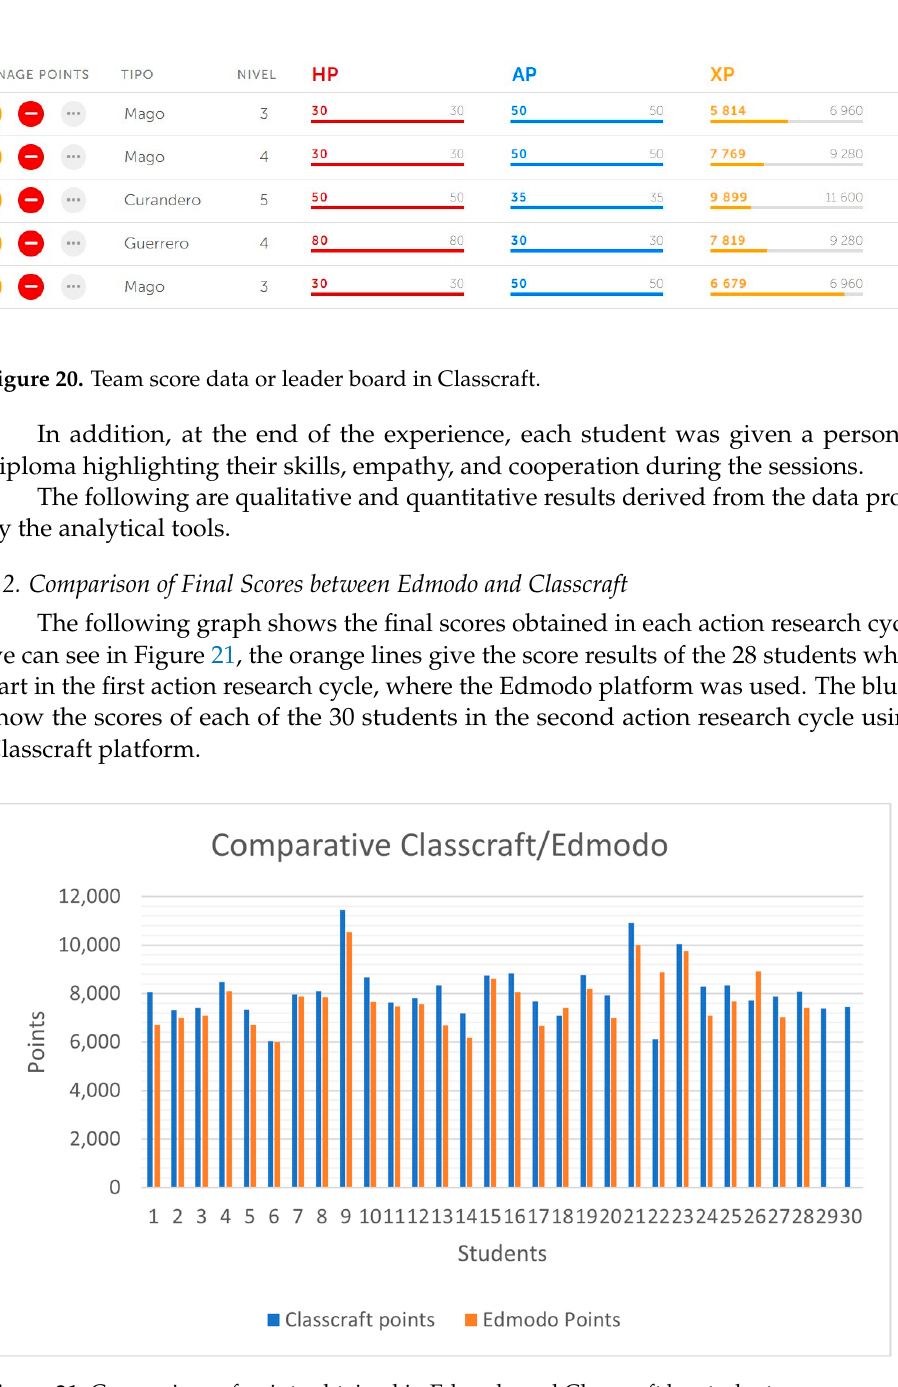
Figure 21. Comparison of points obtained in Edmodo and Classcraft by students.